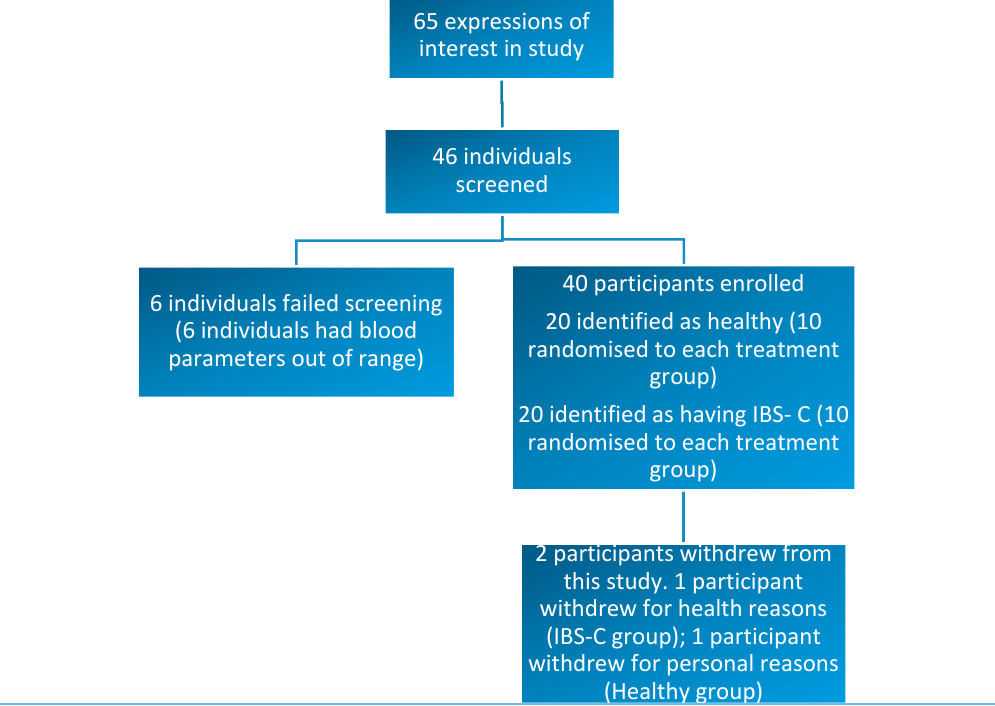
Table 2. Demographics and baseline characteristics of participants in this study.